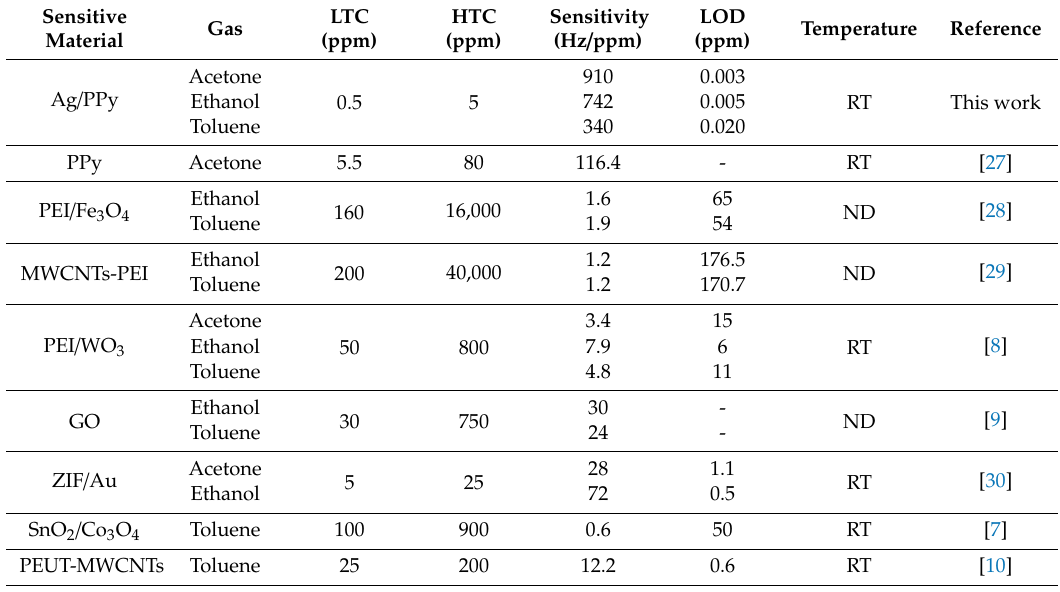
Table 1. Comparative table of state-of the-art SAW sensors and Ag / PPy L-SAW sensors for acetone, ethanol and